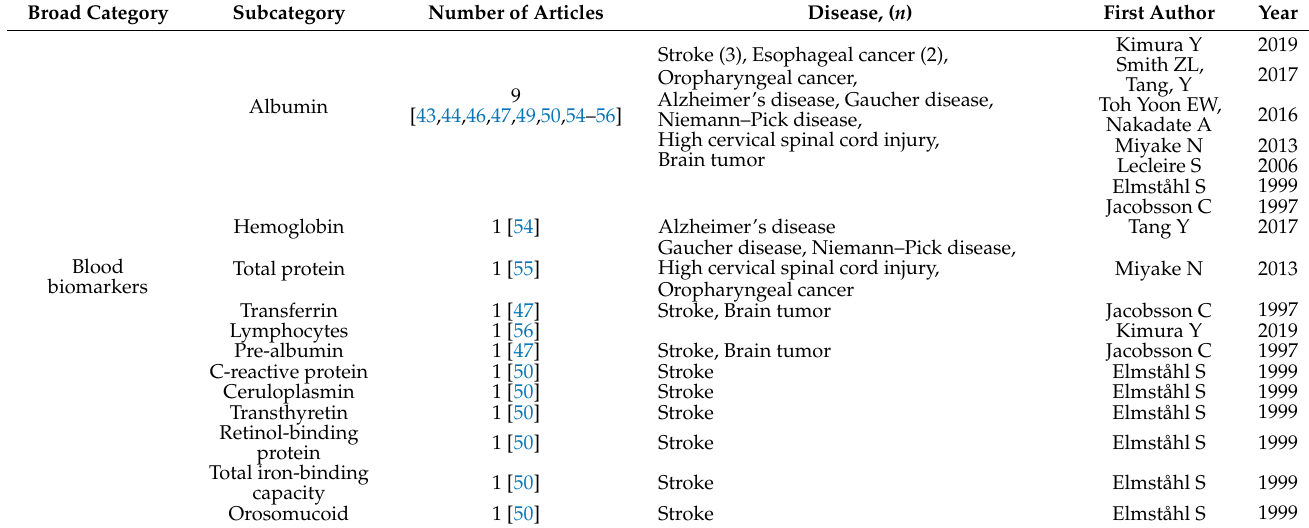
Table 2. Nutritional assessment items related to blood biomarkers for adult patients with dysphagia.